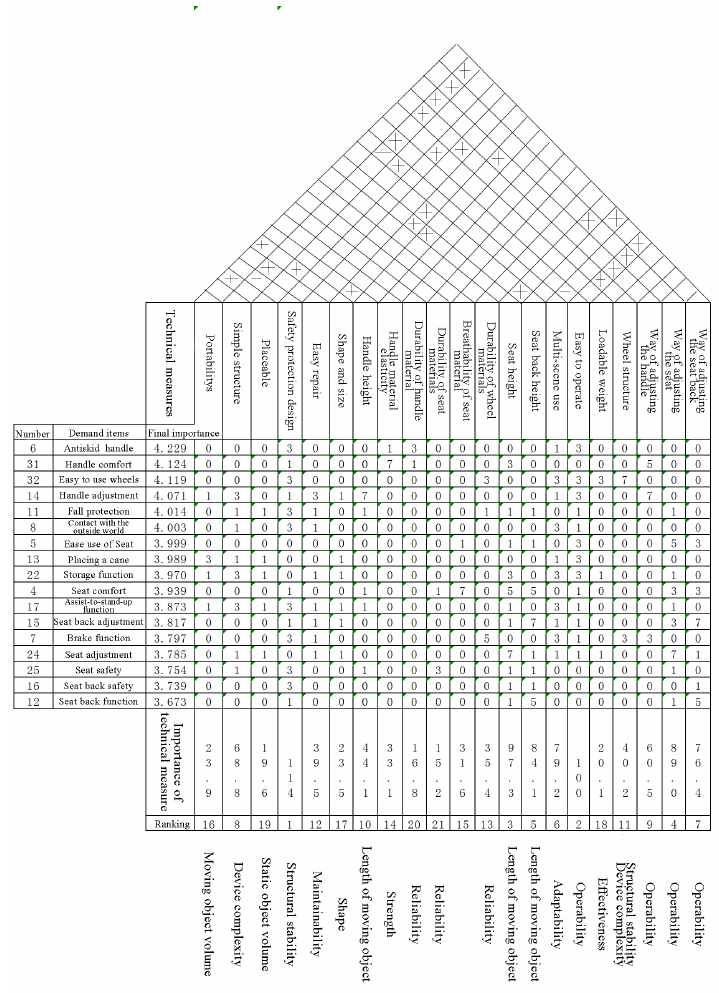
Figure 3. HOQ model of the elder